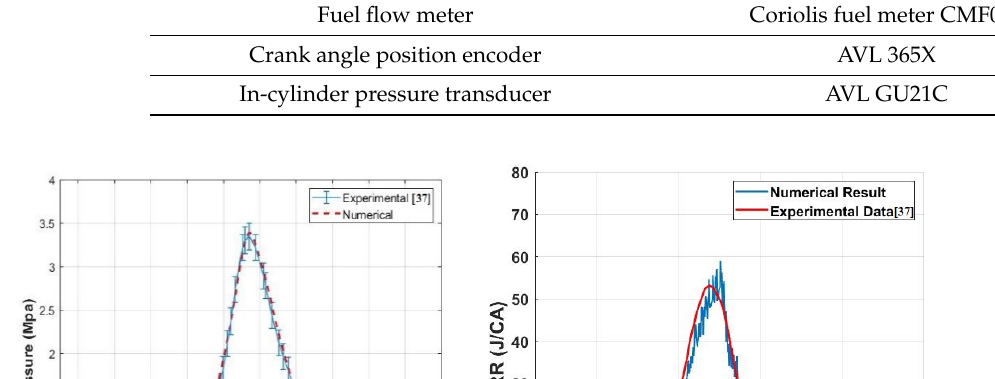
Table 6. Validation of LFS against measured data for R CNG = 100%.